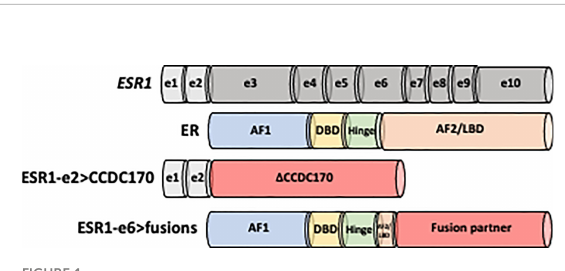
FIGURE 1 Schematic structure of ESR1-e2>CCDC170 and ESR1-e6>fusion proteins. Non-coding exons (e) 1 and 2 are shown as white boxes, while encoding domains in the ESR1 codon structure are presented in gray. ER is comprised of four domains: N-terminal activation function-1 (AF-1), DNA binding domain (DBD), hinge region and C-terminal ligand binding domain (AF-2/LBD). ESR1- e2>CCDC170 fusion proteins retain the fi rst two non-coding exons of ESR1 (ESR1-e2) and link to the coiled-coil domain containing 170 (CCDC170) gene generating truncated CCDC170 proteins ( D CCDC170). ESR1-e6>fusions preserve the fi rst 6 exons of ESR1 (ESR1-e6), while replace the LBD by a 3 ’ fusion